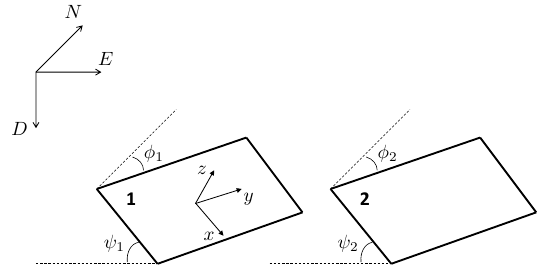
Figure A1. Geometry of the model employed to study the stress transfer between neighbouring faults. Fault 1 is the perturbing fault, while fault 2 is the receiving fault. The coordinates (E,N,D) are the UTM coordinates and depth of the centres of the faults, respec- tively, whereas the axes (x,y,z) correspond with the directions of dip, strike and normal on fault 1, respectively. The angles φ and ψ are the strike and dip angles of the faults,